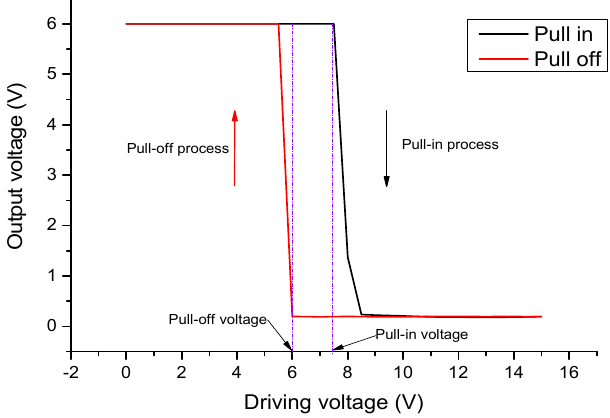
Figure 9. Hysteresis loop of pull-in and pull-off voltage.